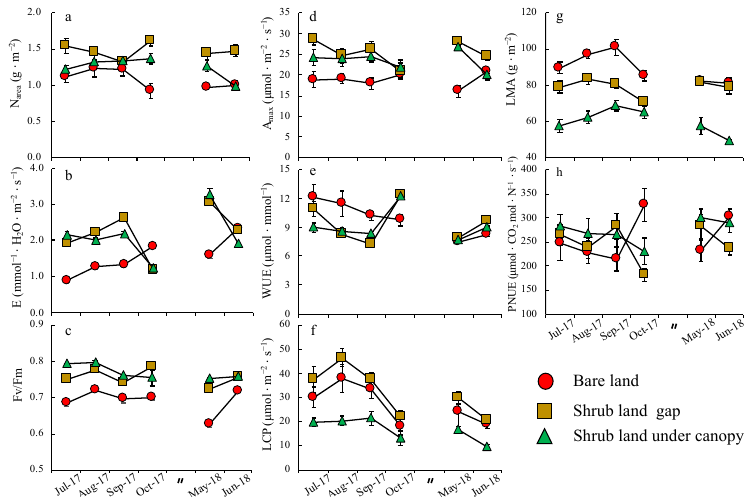
Figure 1. Monthly changes of leaf N content (N area ) ( a ); transpiration rate (E) ( b ); maximum quantum yield of PSII (Fv/Fm) ( c ); light-saturated photosynthetic rate(A max ) ( d ); water use efficiency (WUE) ( e ); light compensation point (LCP) ( f ); leaf mass per area (LMA) ( g ); photosynthetic N use efficiency (PNUE) ( h ) in bare land (BL) (circle), in shrub land gap (SLG) (square) and in shrub land under canopy (SLUC) (triangle). Vertical bars represent the mean ± SE (n = 8).